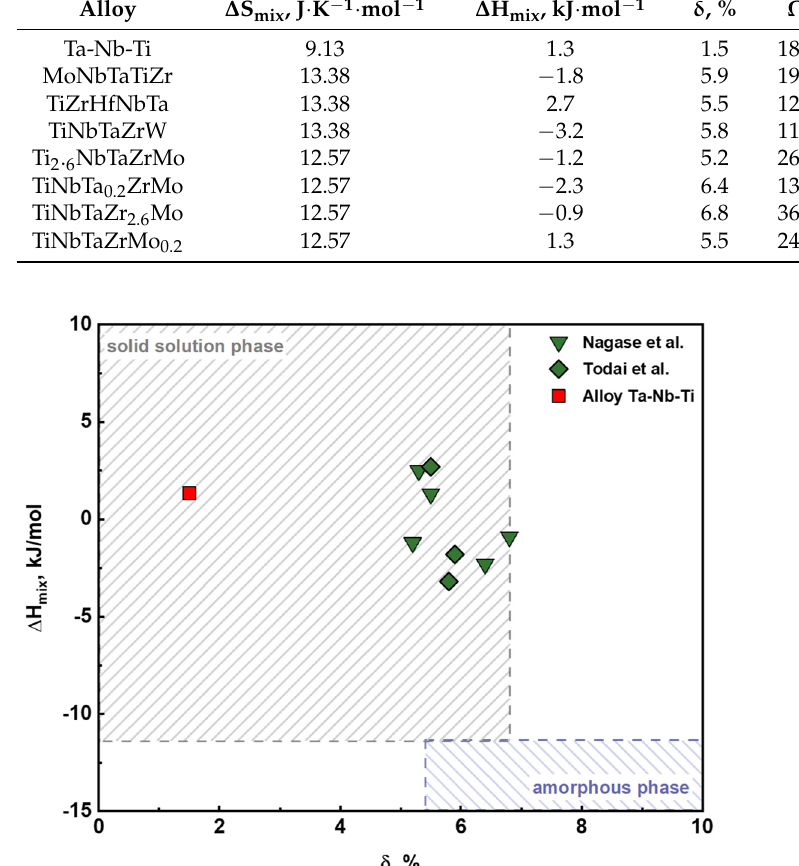
Figure 2. Calculated ∆ H mix - δ plot, focusing on the solid solution phase section and comparing base alloy Ta-Nb-Ti to other relevant Bio-HEAs, from current investigations, data from [16,18,22,32].